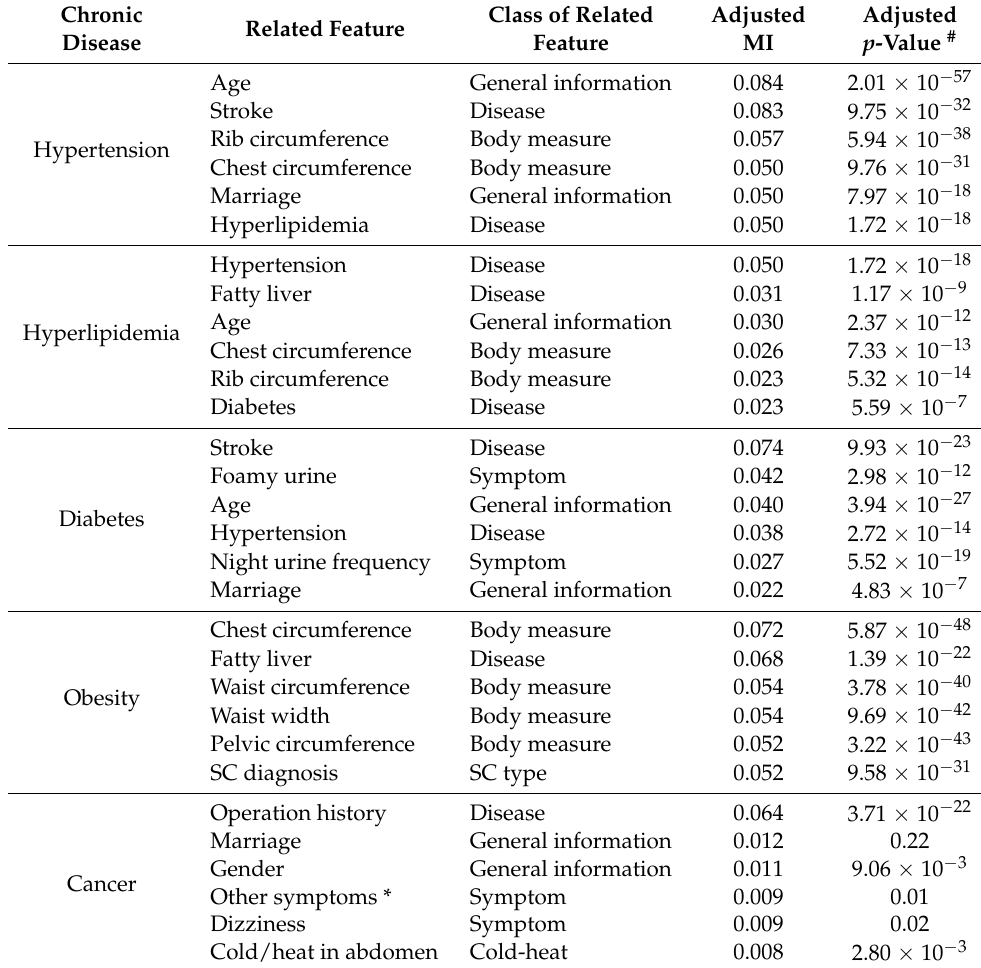
Table 3. Features related to representative chronic